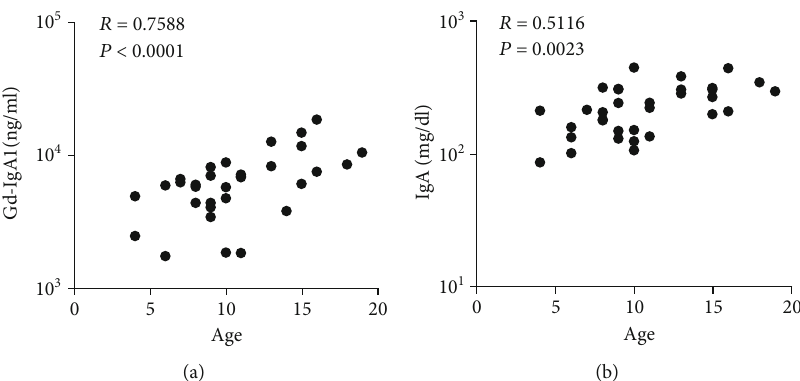
Figure 2: Correlation between age and serum Gd-IgA1 levels and serum total IgA levels in children with IgA nephropathy: (a) serum Gd- IgA1 levels; (b) serum total IgA